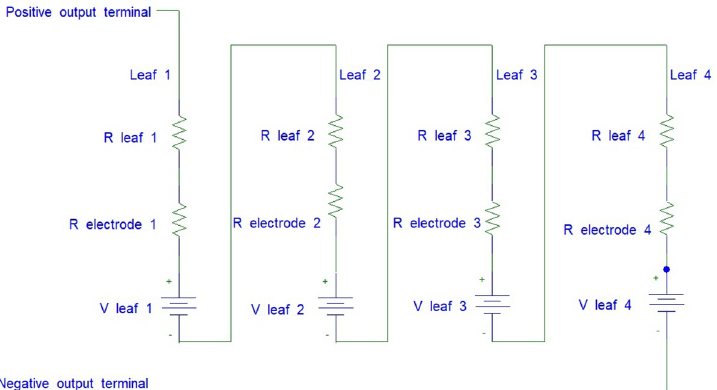
Fig 12. The equivalent circuit for series connection between cut off